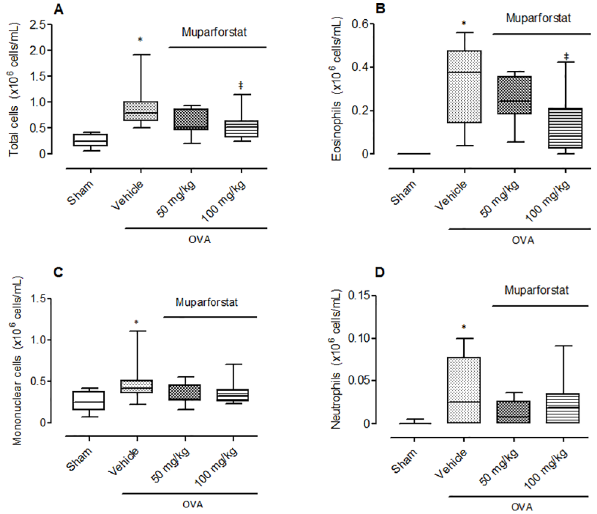
Fig 6. Effect of Muparfostat on allergic inflammation induced by OVA. Box plots showing (A) total cell, (B) eosinophil, (C) mononuclear cell and (D) neutrophil cell number in the lungs of mice following sensitisation and aerosol challenge with OVA. Mice were treated with Muparfostat (50 mg/kg and 100 mg/kg s.c.) 30 minutes before challenge. Mice were challenged with aerosolised 3% OVA for three consecutive days and lavage undertaken 24 h after the last challenge. Data expressed as blox plots with whiskers representing 5 – 95% confidence interval (n = 9 – 15). * p < 0.05 compared with sham and ‡ p < 0.05 compared with vehicle. Data obtained from four independent